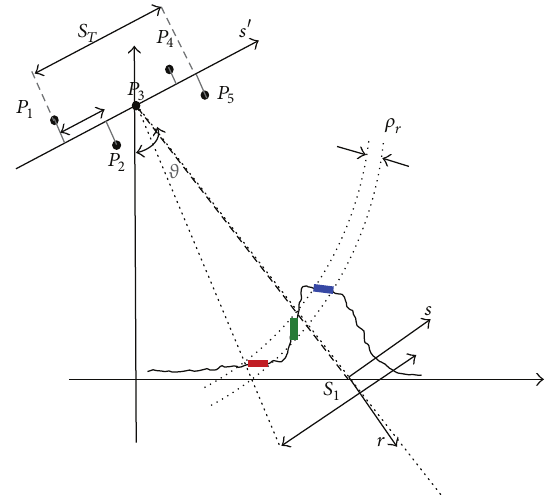
Figure 1: Multipass SAR geometry in the range-elevation plane (case 𝑀 = 5